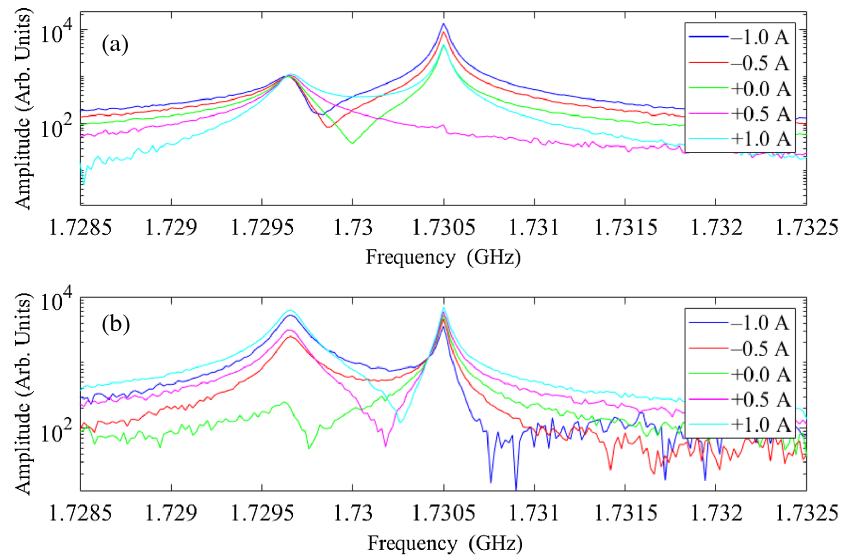
FIG. 14. Horizontal (a) and vertical (b) steering results showing polarization-dependent HOM variations and ∼ 1 -MHz frequency spitting of the two polarizations of dipolar mode 7 in CM2:C8 (RI). Only the vertical polarization component at 1.7297 GHz is responsive to the V125